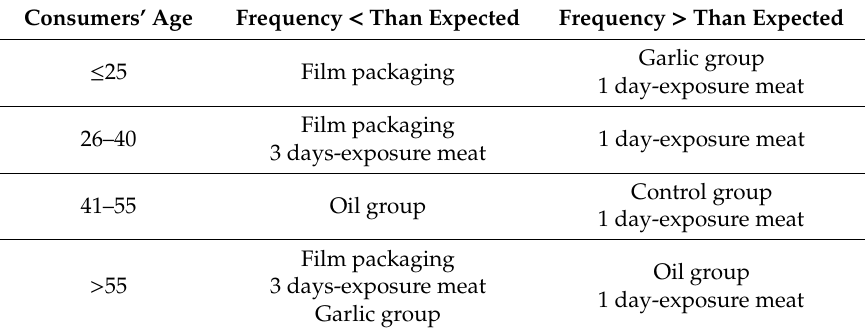
Table 6. Resume of consumer preferences derived from crosstabs between consumer’ age and PDE, pig-sex, packaging type or exposure time.